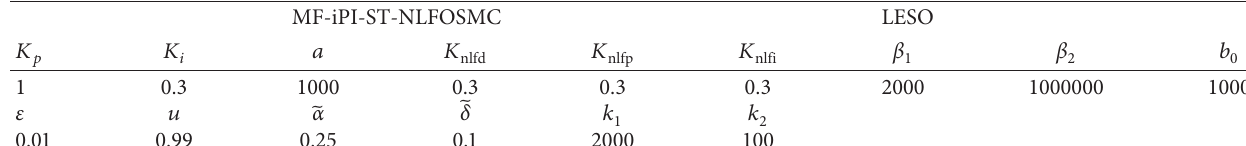
Table 5: Key parameters of the MF-iPI-ST-NLFOSMC.